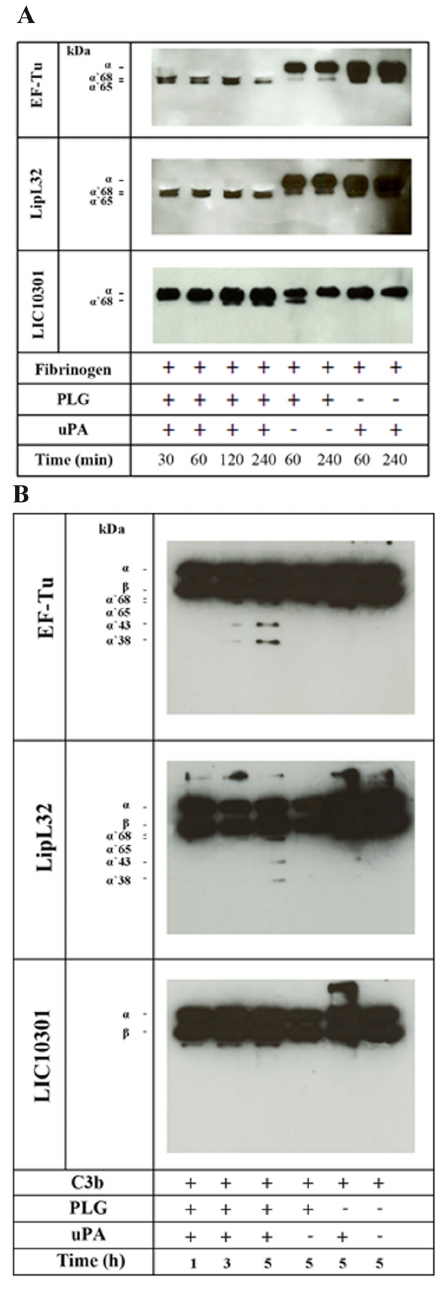
Figure 5. Degradation of human fibrinogen and C3b by plasmin(ogen) bound to immobilized EF-Tu. Plasminogen (20 µg/mL) was added to immobilized recombinant proteins (10 µg/mL). After washing, fibrinogen (500 ng) ( A ) or C3b (500 ng) ( B ) and uPA (3 U) were added, and incubation proceeded for the indicated time points. Samples were separated by SDS- PAGE, transferred to a nitrocellulose membrane, and probed with a mouse monoclonal antibody recognizing the fibrinogen α-chain ( A ) or a goat polyclonal anti-human C3 ( B ) followed by the corresponding secondary HRP-conjugated antibodies. Controls omitting uPA and/or plasminogen were included.